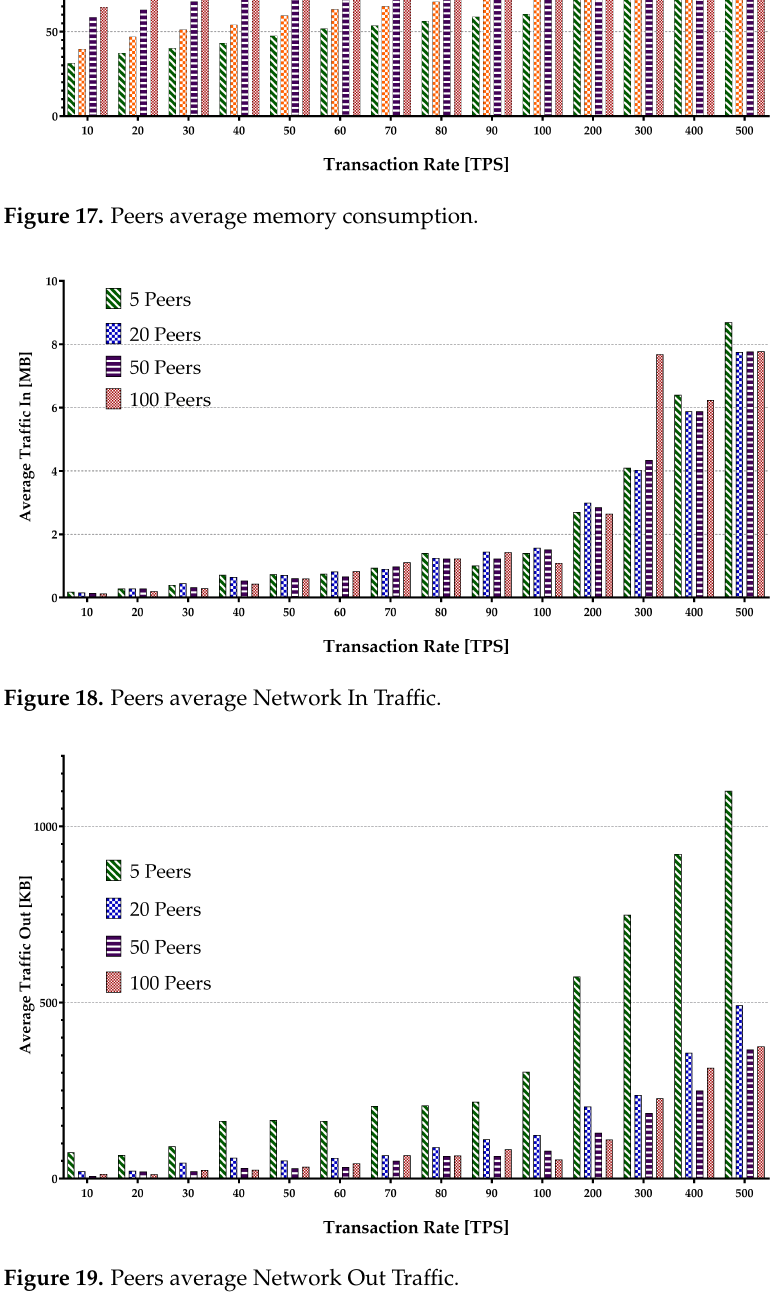
Figure 19. Peers average Network Out